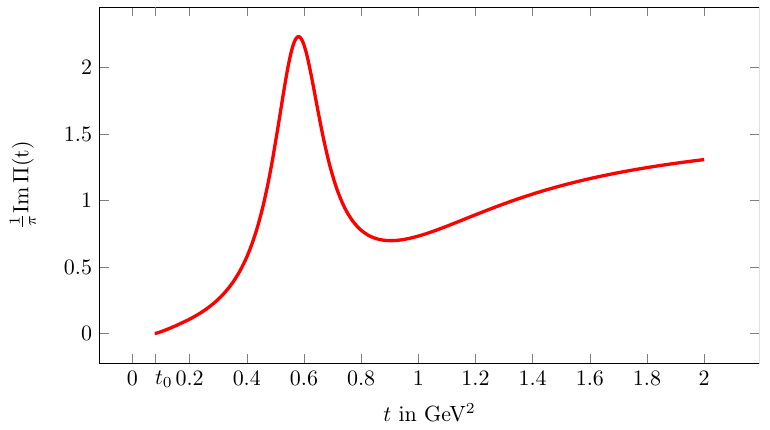
Figure 4 . The model spectral function in eq. (5.1) for t c = 1 GeV 2 and ∆ = 0 . 5 GeV 2 in α